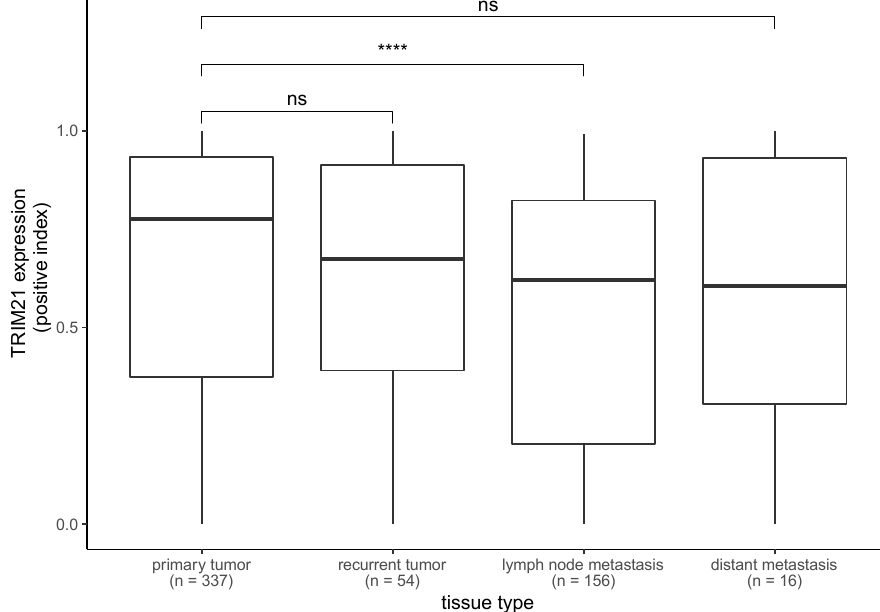
Figure 2. Expression of TRIM21 in PTs compared with LMs, RTs, and DMs. TRIM21 expression in PTs was significantly higher compared with LMs (Mann–Whitney test, p < 0.001). Other comparisons did not reach significance (Mann–Whitney test, p > 0.05). (**** p < 0.001, ns = not significant).